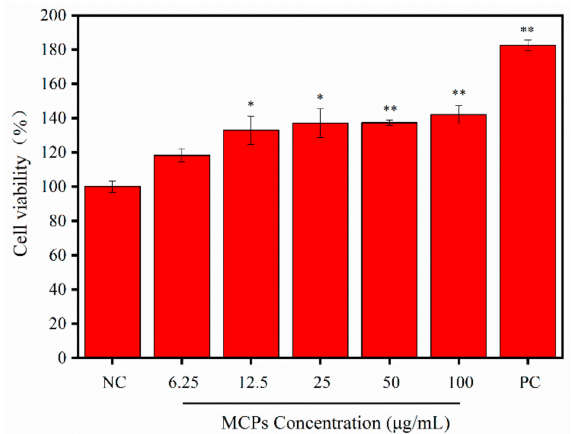
Figure 4. Relative cell viability as a ff ected by 72 h treatment of di ff erent concentrations of MCPs from Nibea japonica skin. Negative control (NC): adding 0.4% serum DMEM to cells; Experimental group: MCP was dissolved by 0.4% serum DMEM in concentrations of 6.25, 12.5, 25, 50, and 100 µ g / mL and then added to the prepared cells; Positive control (PC): adding 10% serum DMEM to cells. * p < 0.05 and ** p < 0.001 vs. NC. The data were expressed as the mean ± standard deviation ( x ± s , n = 6).